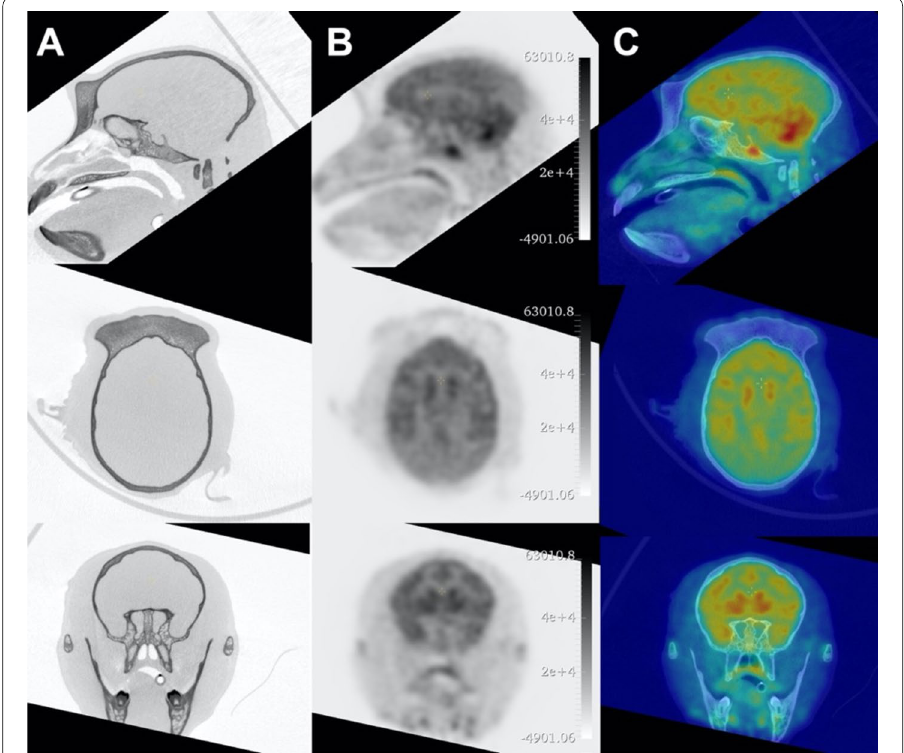
Fig. 6 Coronal, sagittal, and axial slices of (column A) the CT, (column B) the PET, and (column C) the co‑registered PET/CT images of the cerebral uptake of 18 F‑FDG of one Macaca